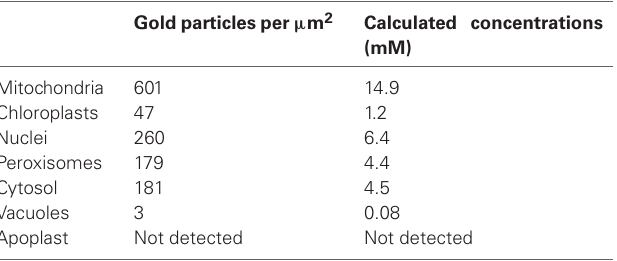
Table 1 | Compartment-specific glutathione contents in leaves of Arabidopsis